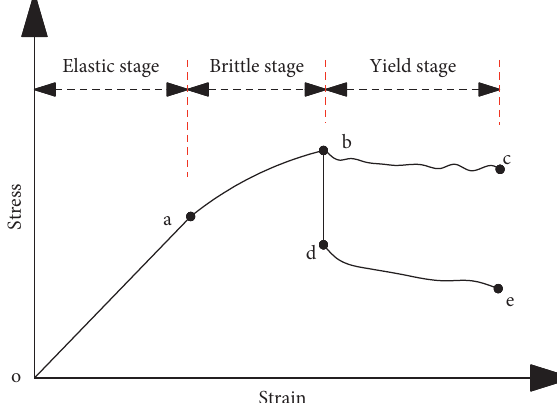
Figure 4: Two typical failure situations during yielding.